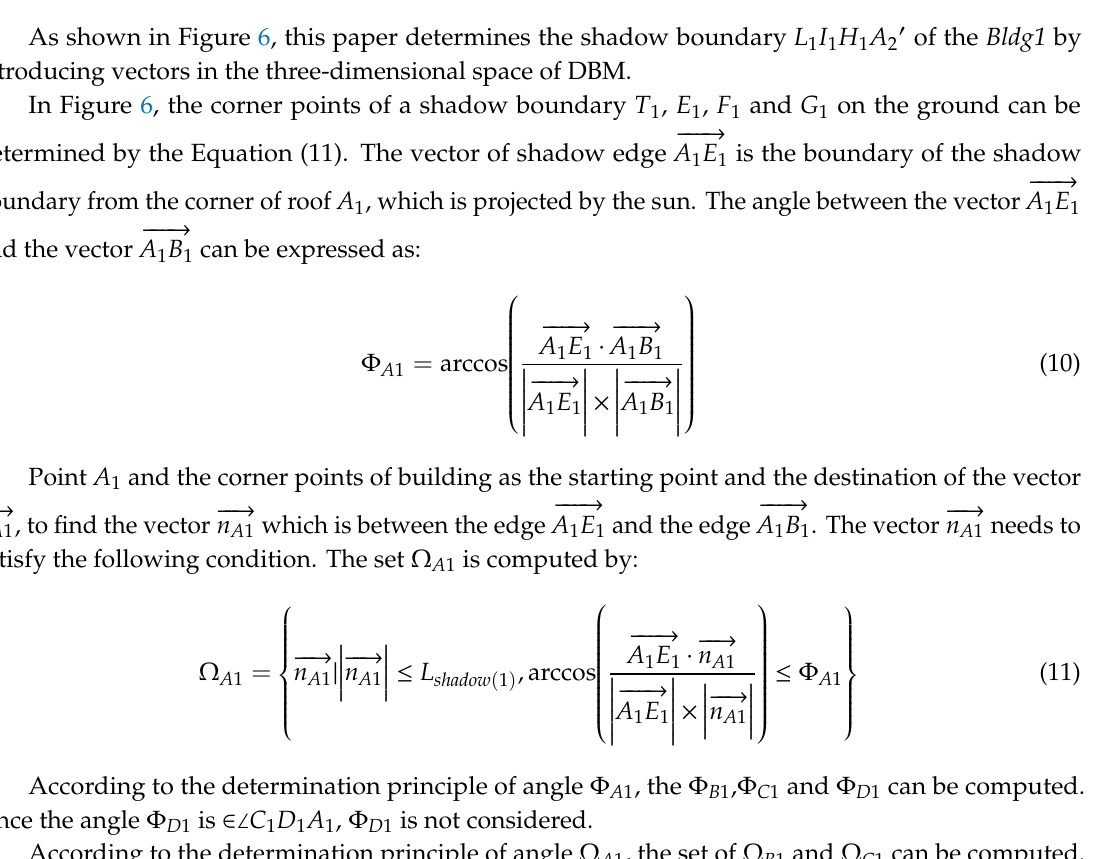
Figure 6. Roof shadow detection method.